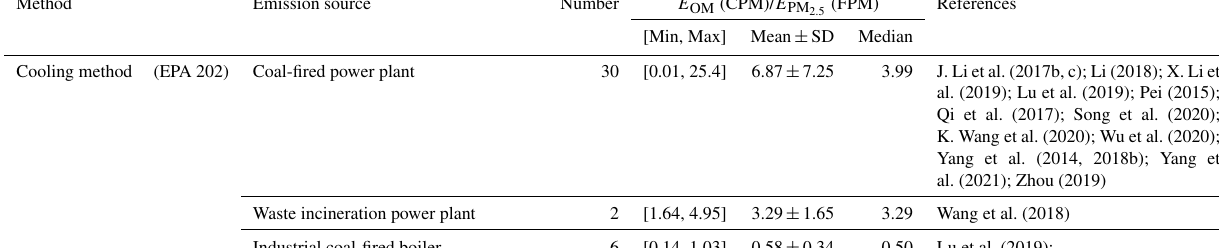
Table 2. List of the ratios of the emission rates of OM in condensable particulate matter (CPM), E OM (CPM), to those of PM 2 . 5 in filterable particulate matter (FPM), E PM (FPM), from stationary combustion sources based on the collected references. 2 . 5